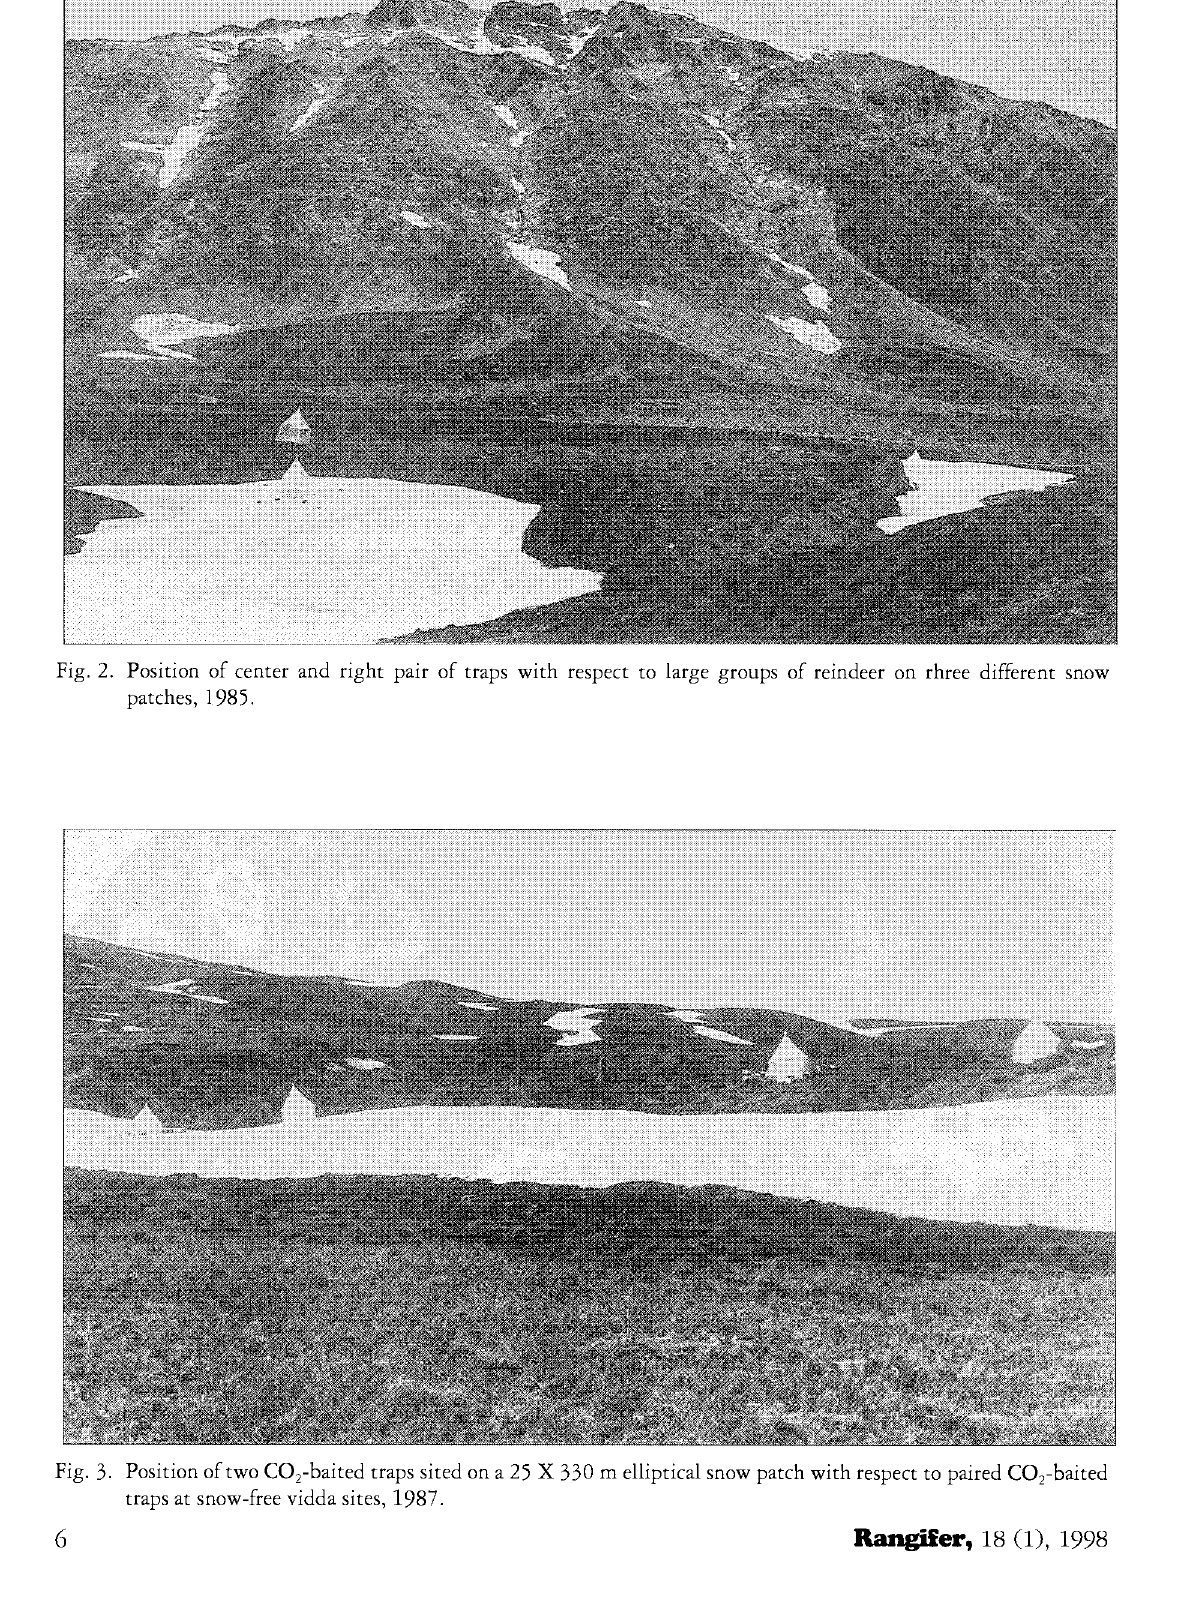
Fig. 3. Position of two C0 -baited traps sited on a 25 X 330 m elliptical snow patch with respect to paired C0 2 traps at snow-free vidda sites,